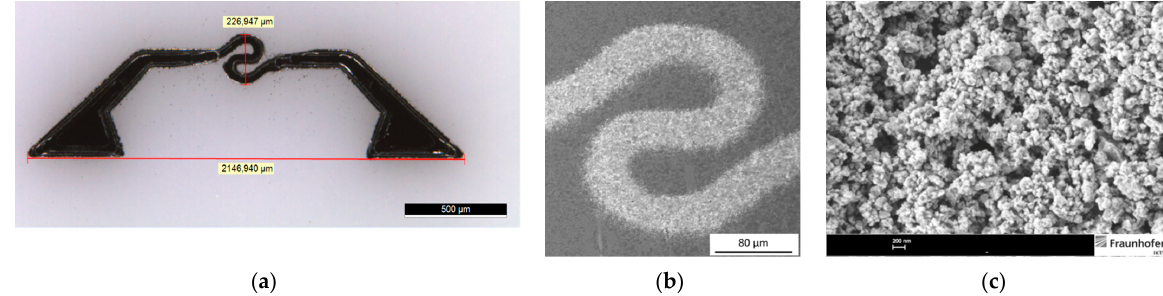
Figure 3. Platinum-printed microhotplate: ( a ) Optical image with dimension (red lines: vertical ~ 227 μ m and horizontal ~ 2147 μ m) platinum microhotplate printed by an aerosol-jet system on a thin 3YSZ substrate before firing; ( b ) SEM image of the aerosol-jet printed heater after sintering; and ( c ) SEM image of milled glass powder <500 nm, which was used for the Pt-glass ink.